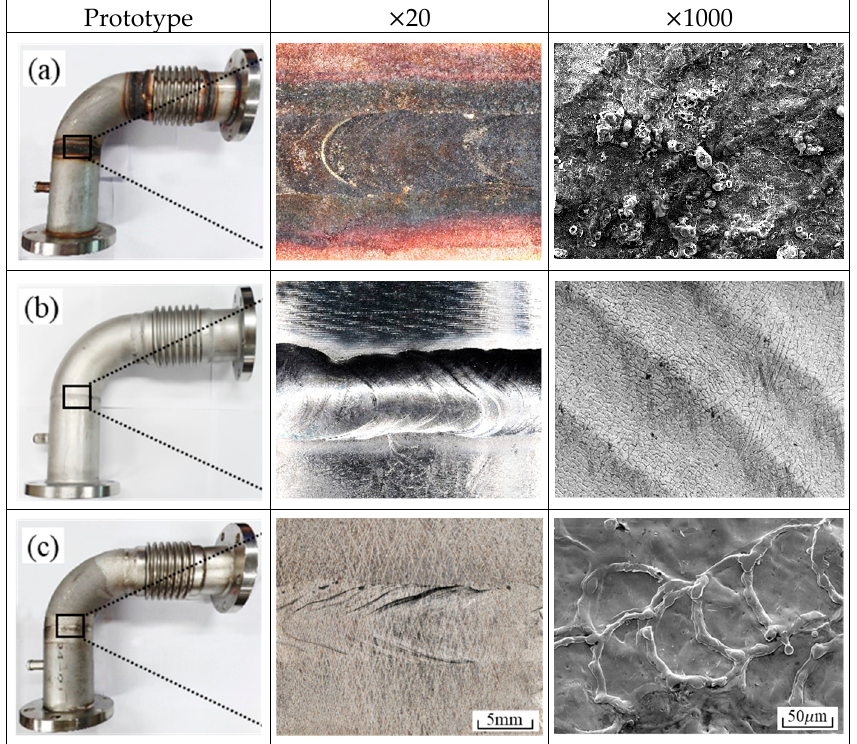
Figure 11. Surface images of prototypes before and after cleaning; ( a ) Before cleaning, ( b ) Chemical cleaning, ( c ) Laser cleaning.